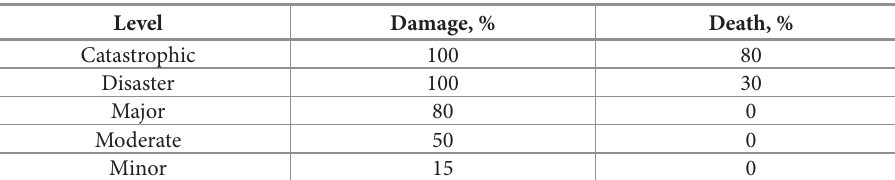
Table 1. Accident type and severity